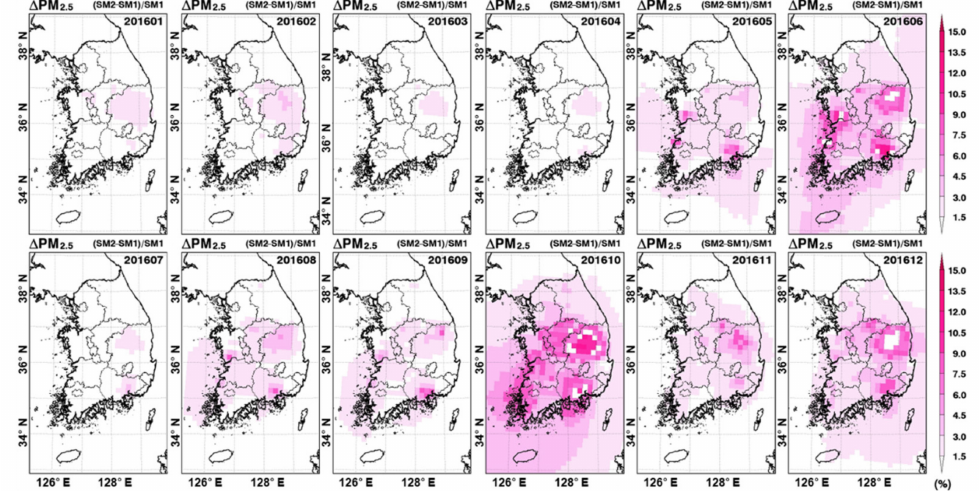
Figure 10. Spatial distributions of monthly relative differences in PM 2.5 between SM1 and SM2 simulations (unit: %).